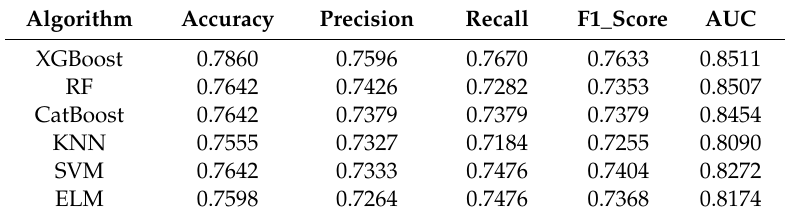
Table 5. Results for Immunoglobulin A nephropathy (IgAN) prediction.